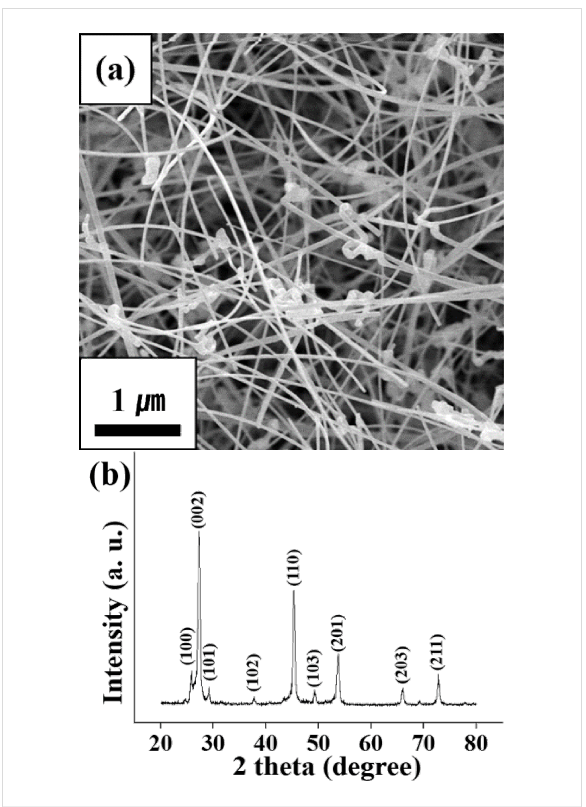
Figure 1: (a) SEM image of ZnSe nanowires. (b) XRD pattern of the ZnSe nanowires.